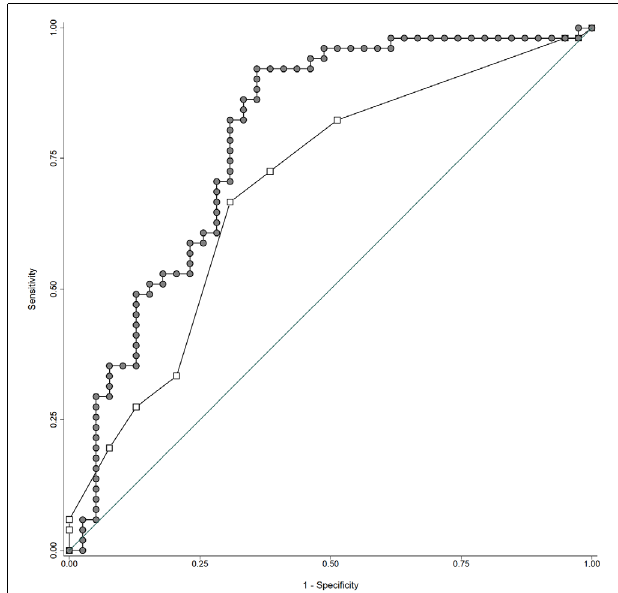
FIGURE 1 | ROC curves for qualitative (continuous line: area under the curve of 0.69) vs. mixed imaging data (area under the curve of 0.79). Note that the addition of quantitative imaging parameters significantly improves the accuracy of the regression models in predicting the cognitive outcome (worsened vs. unchanged or improved). See text for